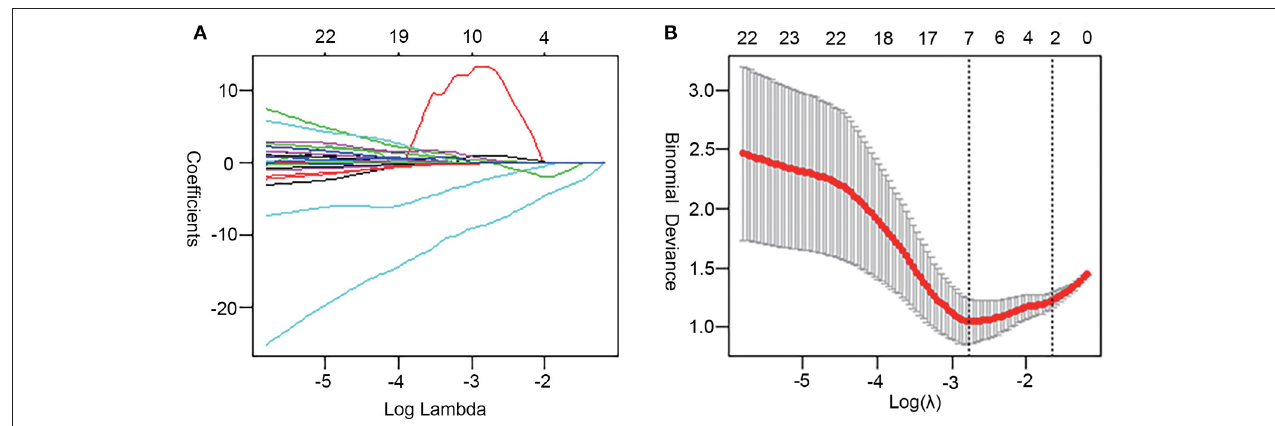
FIGURE 3 | Feature selection by LASSO regression. (A) LASSO coefficient sketch of 99 features. With increasing lambda, the coefficient of unimportant features gradually tended to 0. (B) The deviance profile was made by adjusting the optimal regularization parameters ( λ ) based on 10-fold cross-validation. The left dashed line delineates the minimum norm and the right indicates 1-standard error norm (1-SE). This study utilized the minimum norm.